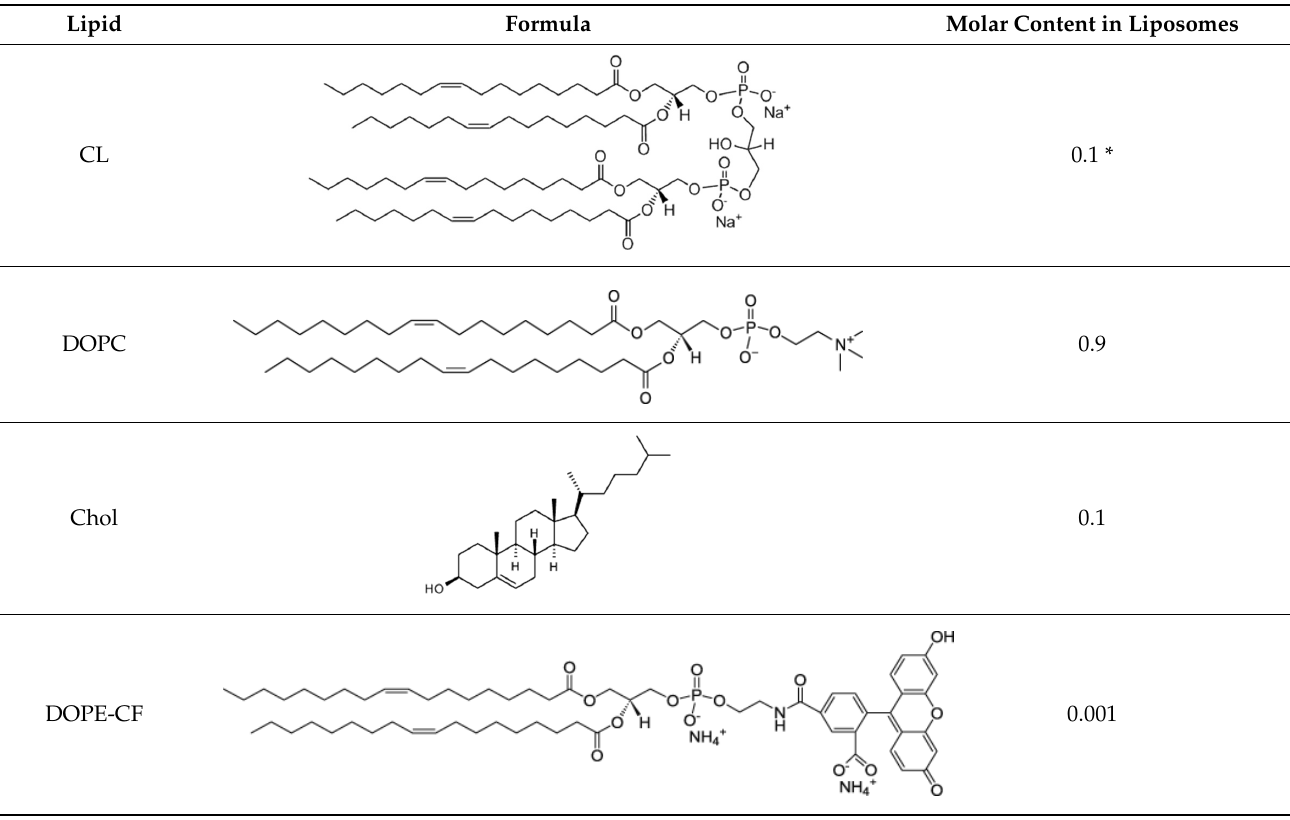
Table 3. Lipids for liposome